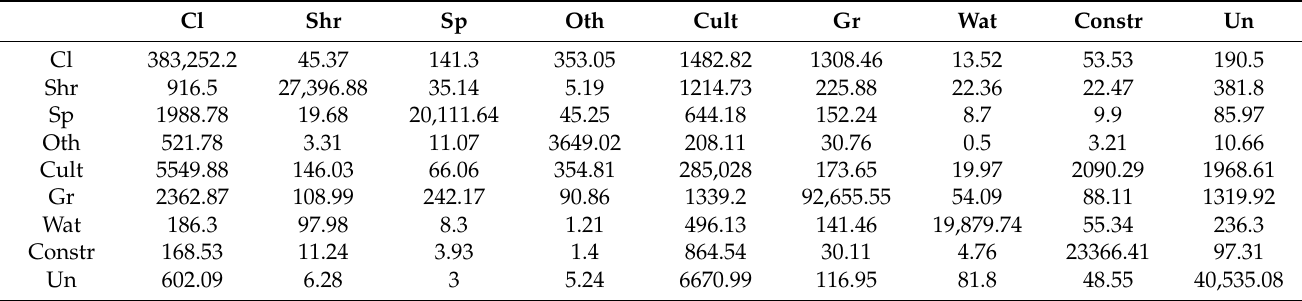
Table 9. Conversion of Land Types from 2020 to 2030EP (km 2 ).